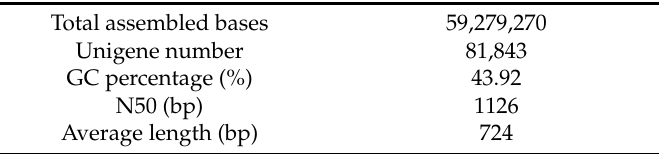
Table 2. Statistics of assembly